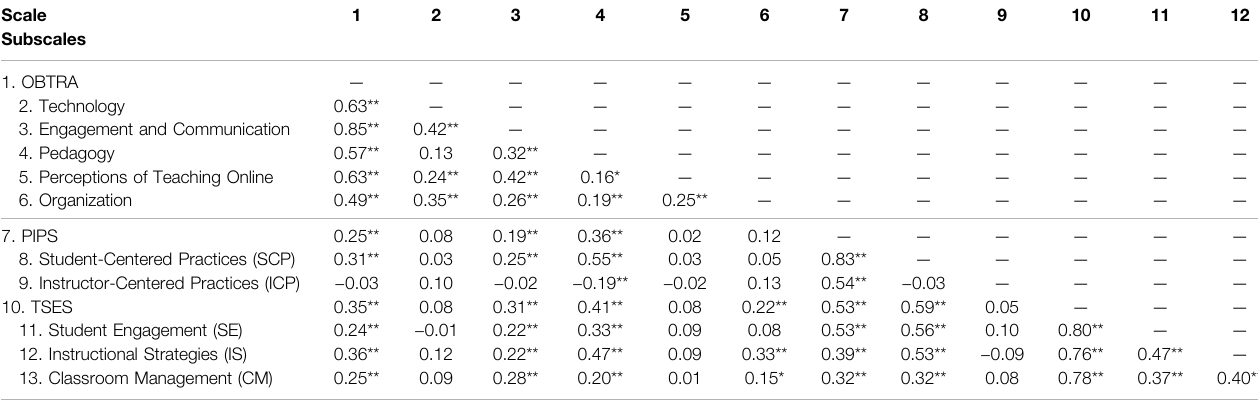
TABLE 4 | Correlations between the Online and Blended Teaching Readiness Assessment (OBTRA), Postsecondary Instructional Practices Survey (PIPS), teachers ’ Sense of Ef fi cacy Scale (TSES). Scale